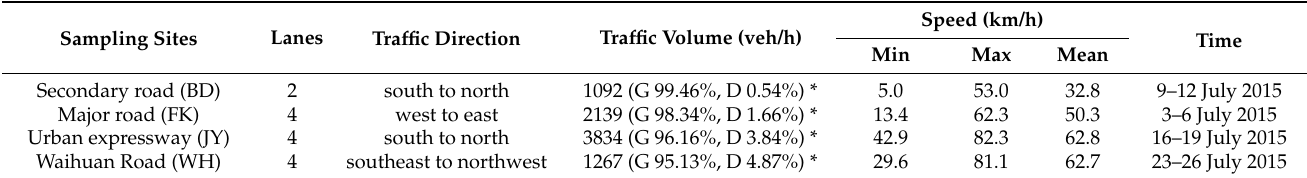
Table 1. Traffic flow data of sampled sites.